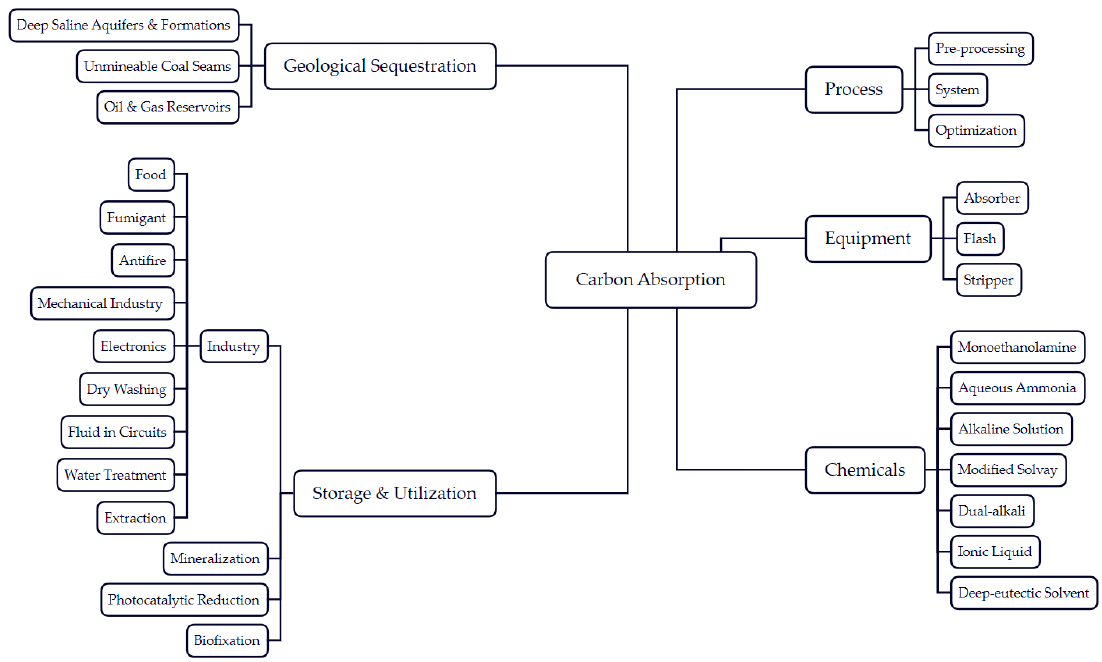
Figure 5. The ontology schema of carbon capture and storage technologies.